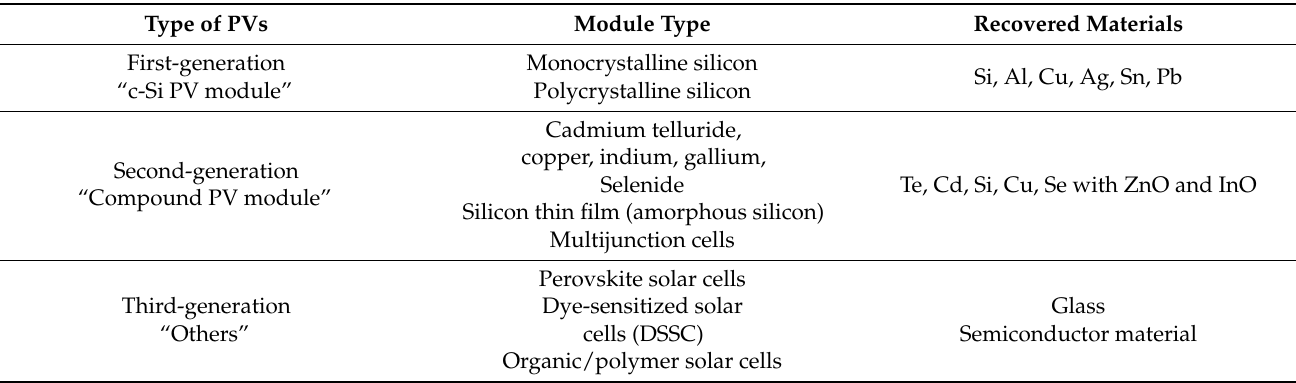
Table 1. End-of-life management of PV solar panels.